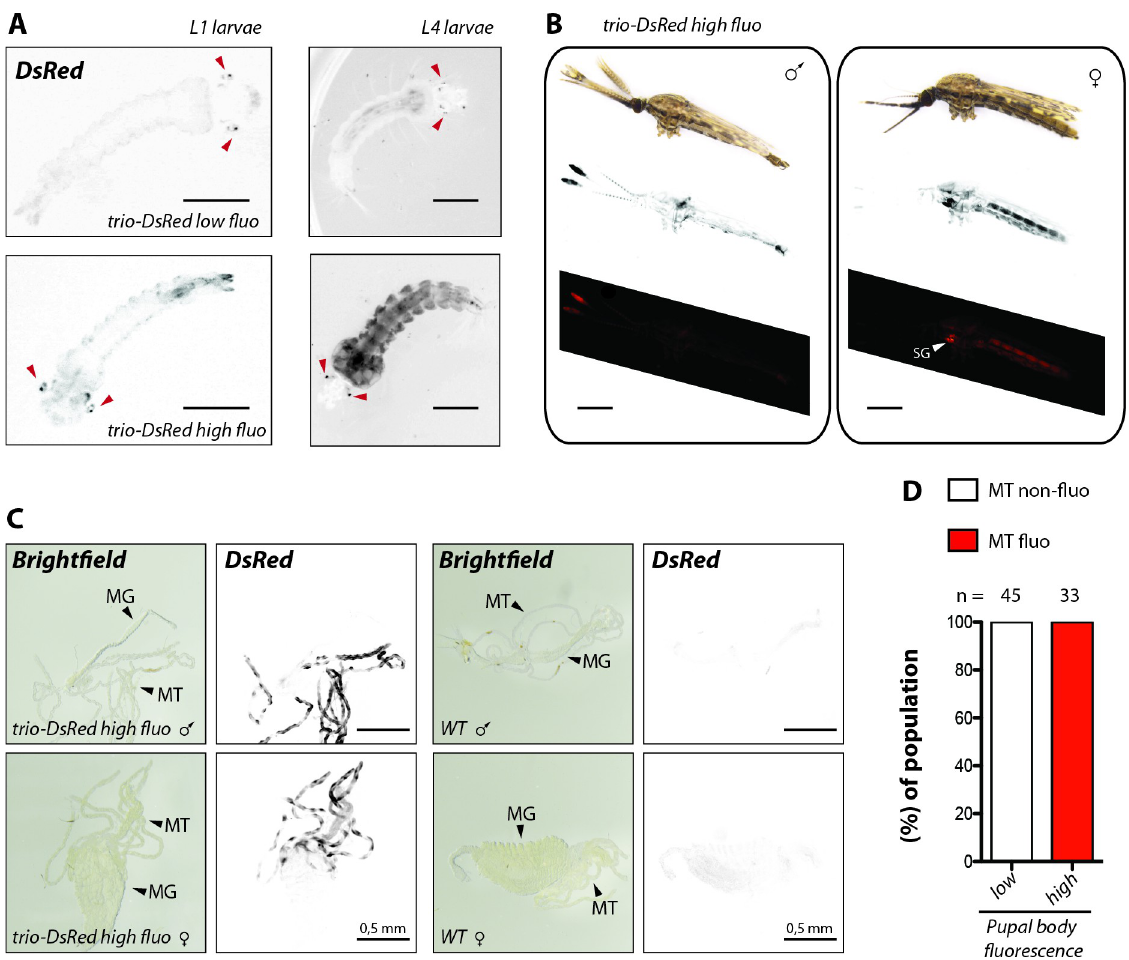
Fig 5. DsRed expression in Malphigian tubules (MT) of trio-DsRed mosquitoes is linked to ubiquitous DsRed expression in larvae, pupae and adults. A) Trio-DsRed L1 and L4 larvae were classified as trio-DsRed low fluo or trio-DsRed high fluo according to their body DsRed fluorescence intensity. Red arrowheads point towards the DsRed positive eyes observed in the majority of larvae. Scale bar L1: 250 μ m. Scale bar L4: 0.5 mm. B) Whole body fluorescence of trio-DsRed high fluo male and female mosquitoes. From top to bottom: brightfield, inverted DsRed fluorescence signal displayed in black and white and in red on black. Note that images were stitched from two separate images showing either the head or the abdominal part. Scale bar: 0.5 mm. C) Representative images of male and female midguts dissected from mosquitoes that displayed high body fluorescence at the pupal stage in comparison to wild type (WT: G3 ). Malphigian tubules (MT) and midguts (MG). Scale bar: 0.5 mm. D) Correlation of high body fluorescence at the pupal stage with DsRed expression in malphigian tubules (MT). Data were collected from two different mosquito generations. The number of analyzed mosquitoes is indicated above each